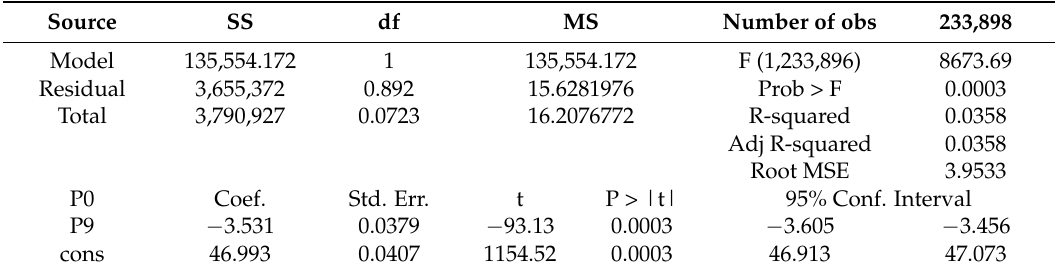
Table 8. Regress P0–P9-Monthly Rainfall.